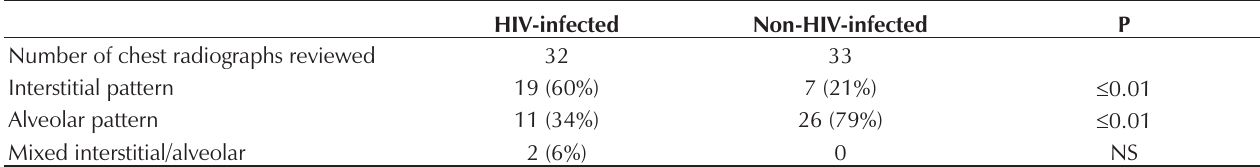
Abnormalities on admission chest radiographs of HIV- and non-HIV-infected patients with community-acquired pneumonia HIV-infected Non-HIV-infected